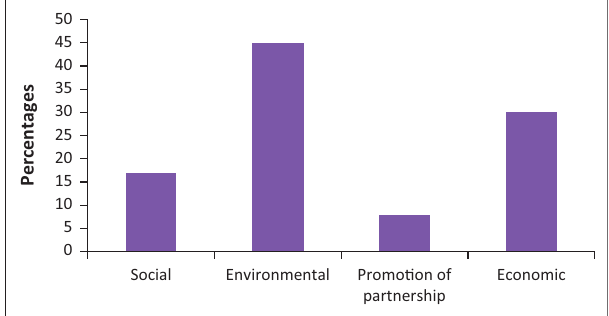
FIGURE 4: Benefits of guiding developments in flood-prone